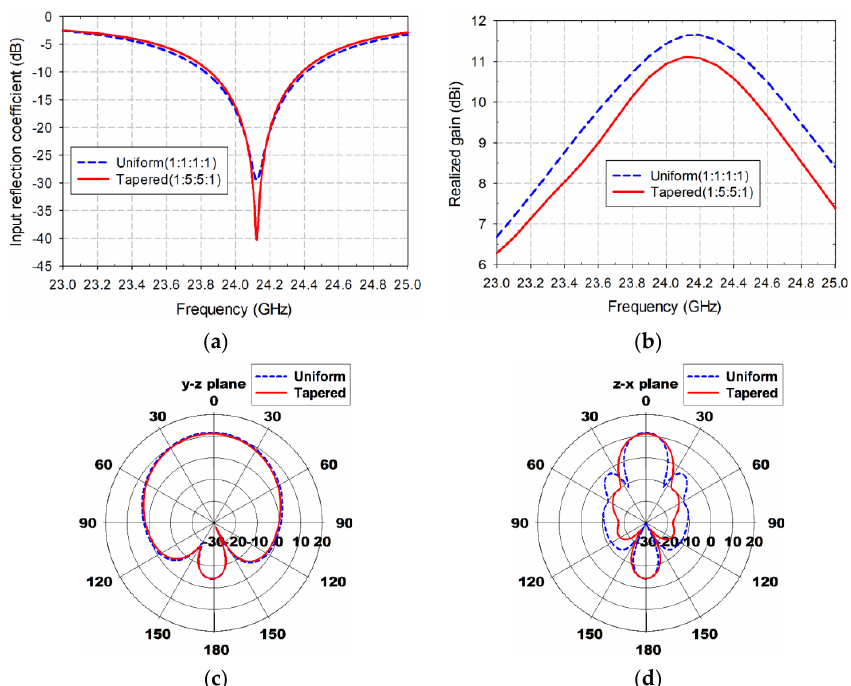
Figure 6. Performance comparison of the 4 × 1 microstrip square patch array antenna combined with shunt-connected series feed networks using uniform and tapered power distributions: ( a ) the input reflection coefficient, ( b ) the realized gain in the + z -axis direction, ( c ) the radiation patterns on the y–z plane at 24.125 GHz, and ( d ) the radiation patterns on the z–x plane at 24.125 GHz.